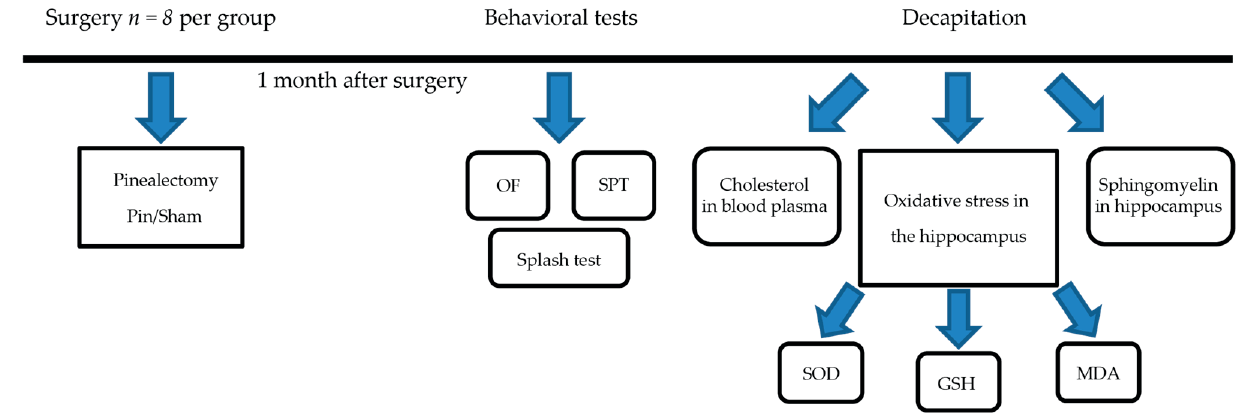
Figure 8. Experimental protocol with description of procedures and the number of animals used per group.